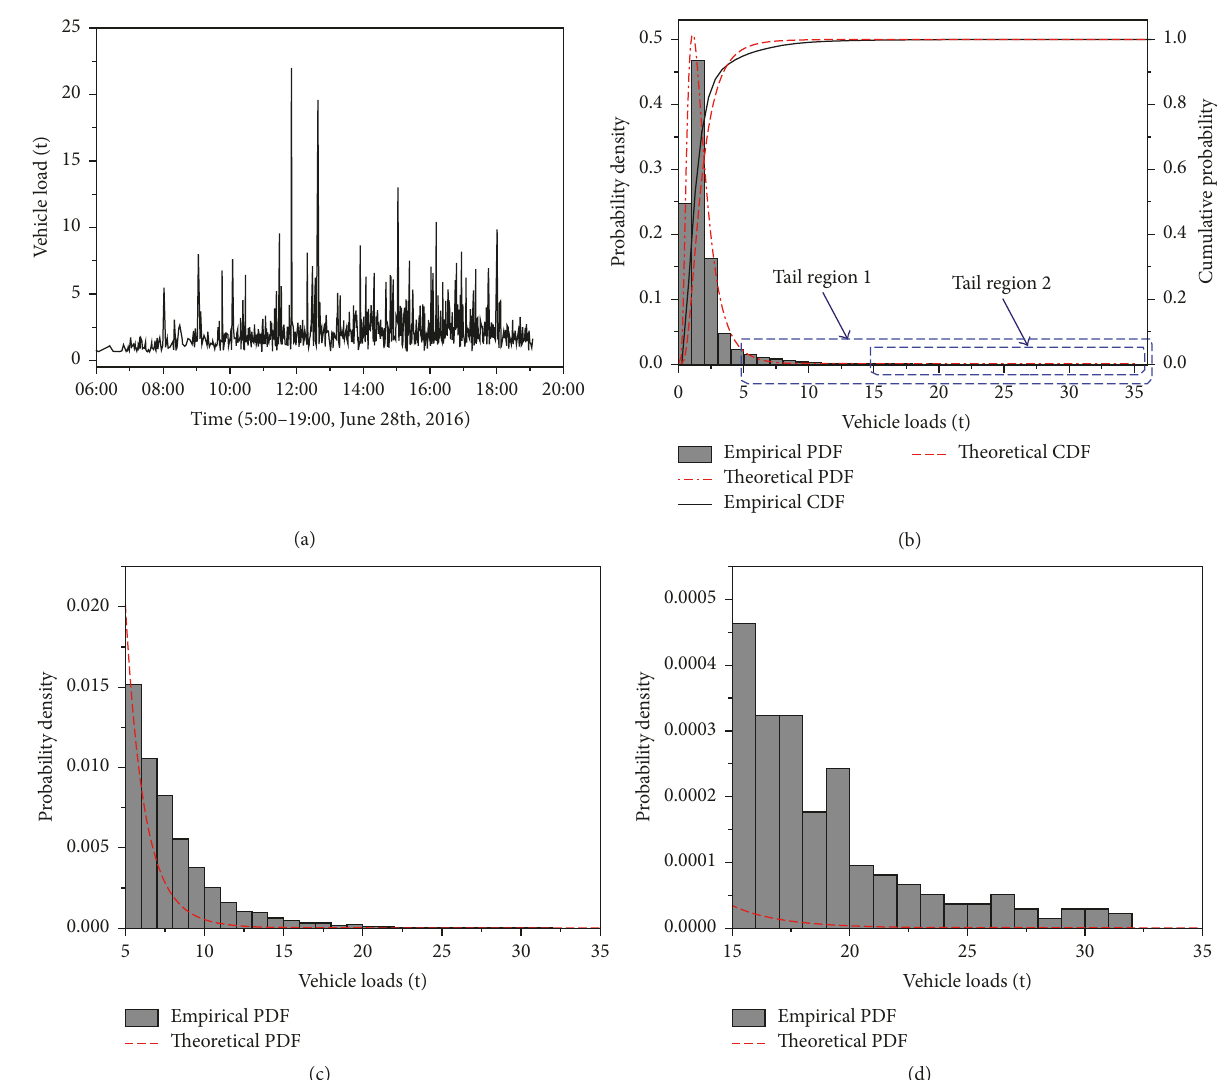
Figure 6: Time history and log-normal fit of the vehicle load: (a) actual load history of vehicle load, (b) entire ranger, (c) tail region 1, and (d) tail region